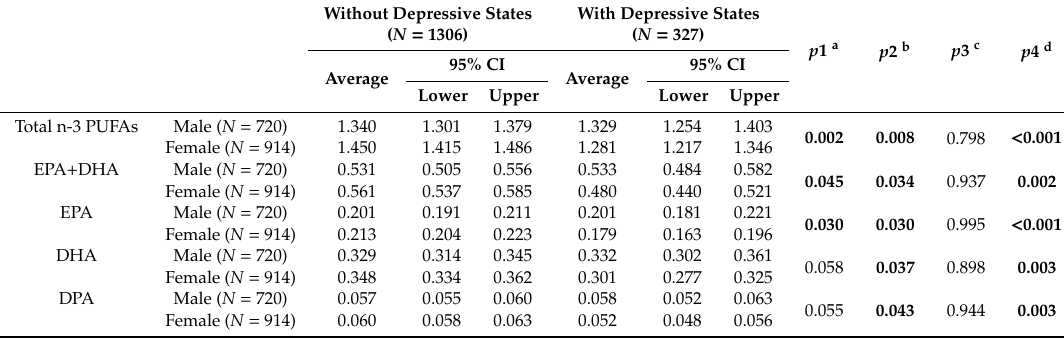
Table 3. Influence of sex on the association between n-3 PUFAs intake and depressive states (two-way ANOVA). Without Depressive States ( N =